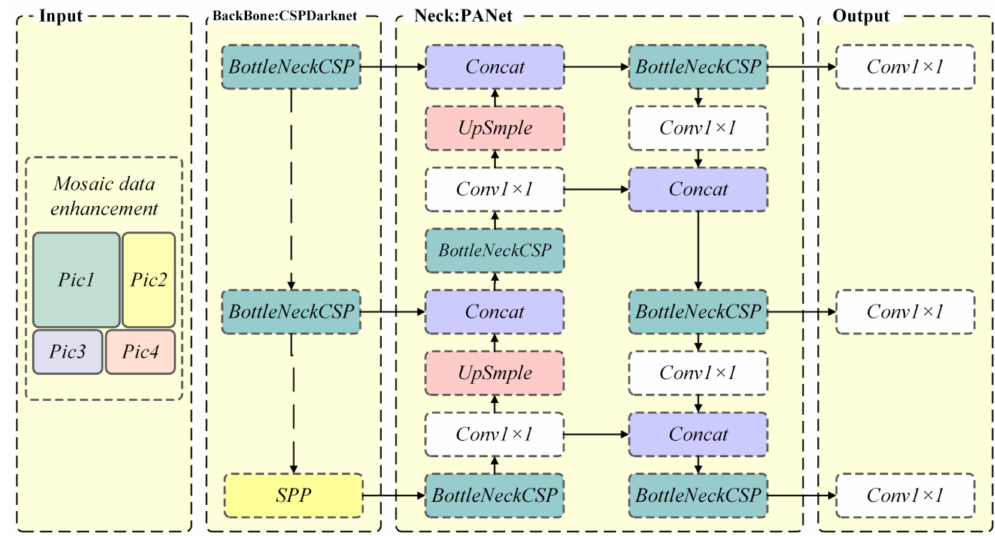
Figure 6. Structure of the YOLOv5